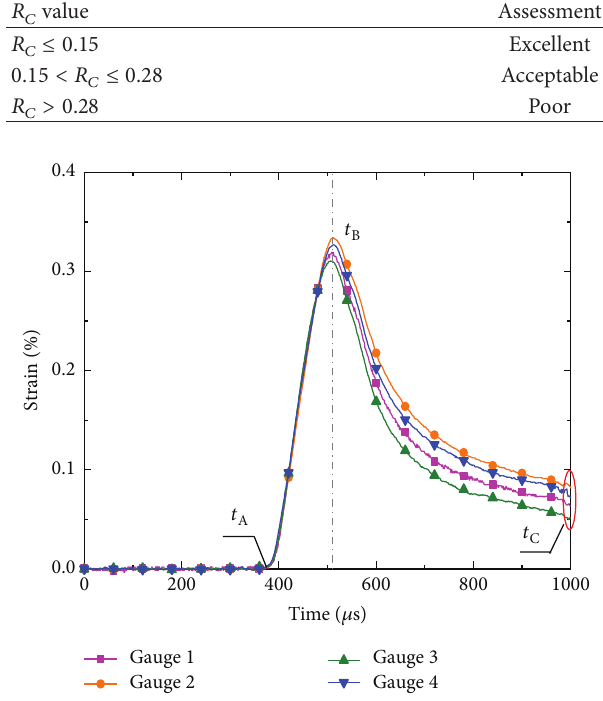
Figure 6: Strain signals captured by strain gauges on the specimen under impact